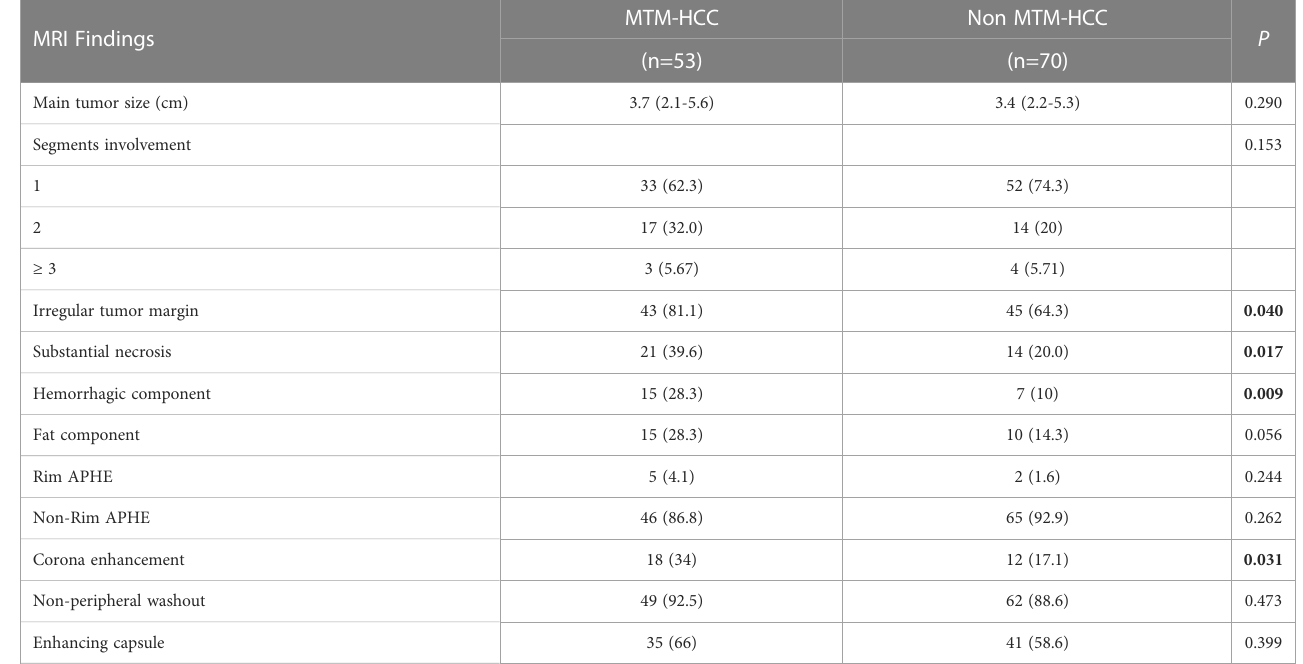
TABLE 3 Mri fi ndings of hcc lesions in the primary cohort according to macrotrabecular-massive subtype.